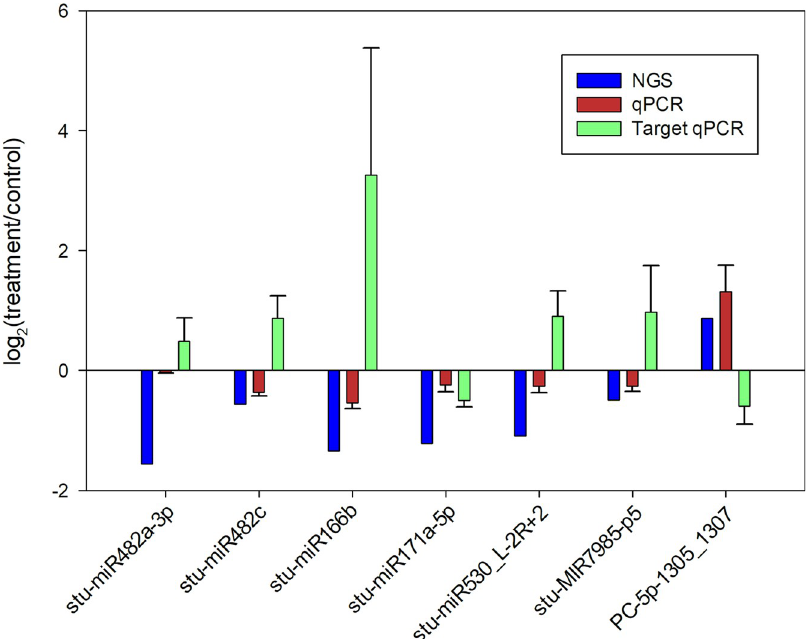
Fig 4. Validation of next generation sequencing (NGS) results for selected differentially expressed miRNAs and analysis of selected target genes. Quantitative real time PCR (qPCR) was performed to validate differentially expressed miRNAs (stu-miR482a-3p, stu-miR482c, stu-miR166b, stu-miR171a-5p, stu-miR530_L-2R+2, stu- MIR7985-p5, PC-5p-1305_1307) and targets (TIR-NBS-LRR resistance protein, Resistance protein PSH-RGH7, BZIP domain class transcription factor, Methylketone synthase Ib, Zinc knuckle (CCHC-type) family protein, Spotted leaf protein, F-box protein family). The EF1 α gene was used as housekeeping. Three biological replicates were employed. Vertical bars represent the standard deviation of the mean (n = 3).